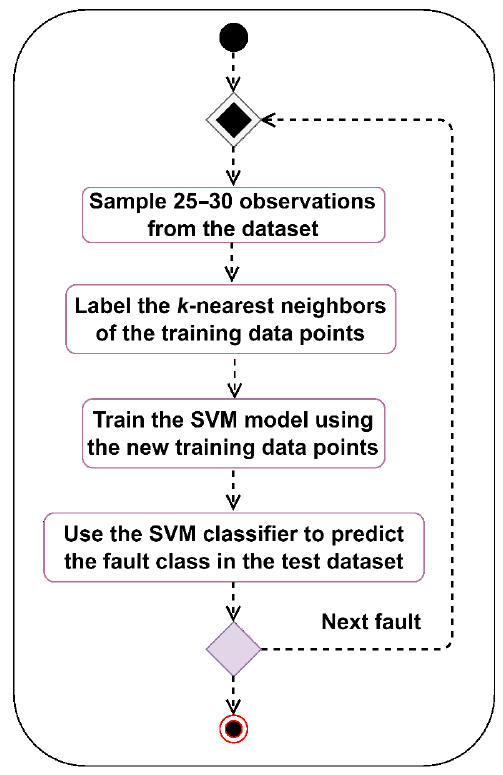
Fig. 3 Method 2: Combination of SVM and unsupervised learning of the k -NN labeling.